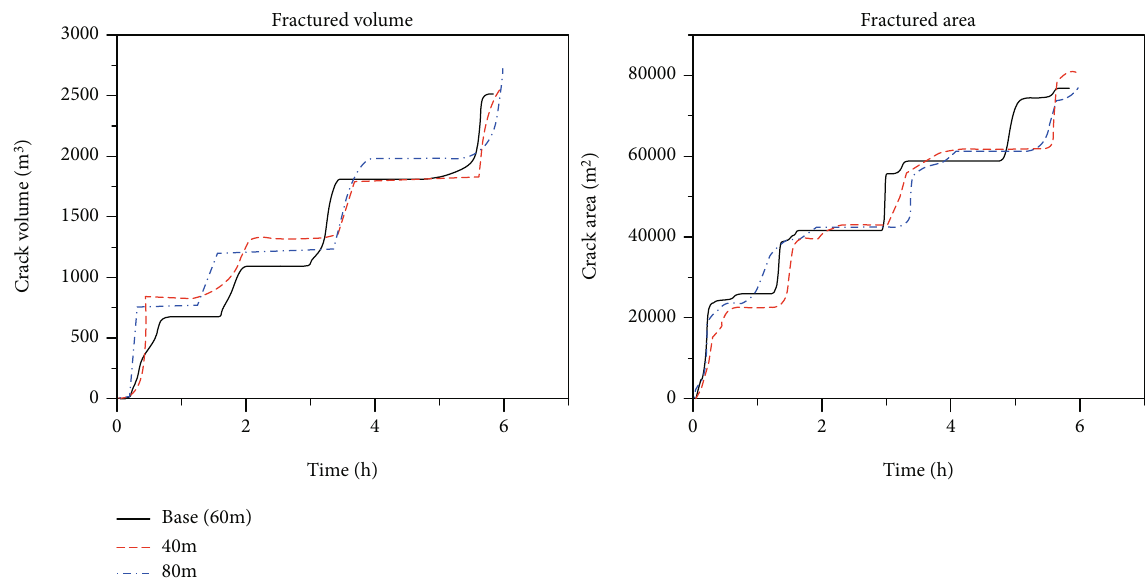
Figure 6: Evolutions of fractured volume and area for scenarios with di ff erent stage spacings.